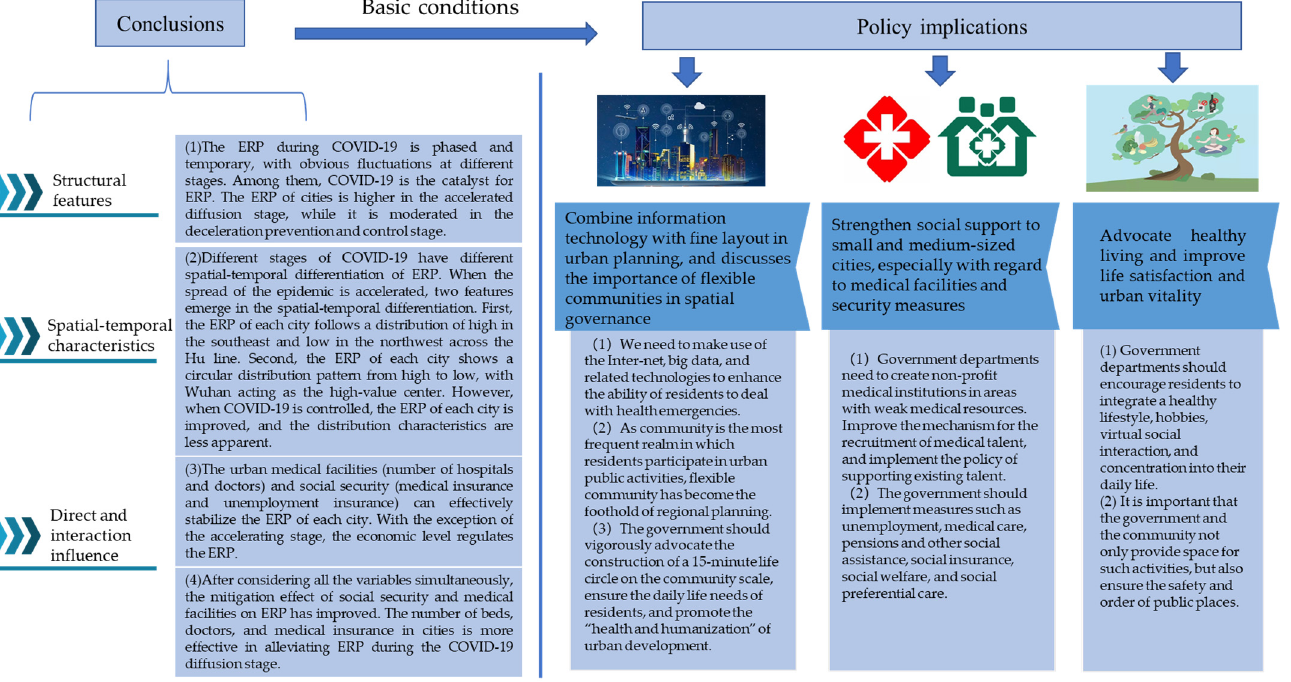
Figure 8. Research conclusions and policy recommendations.